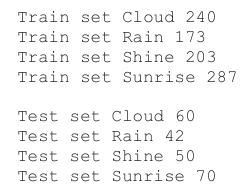
Fig. 1. Prepare dataset.